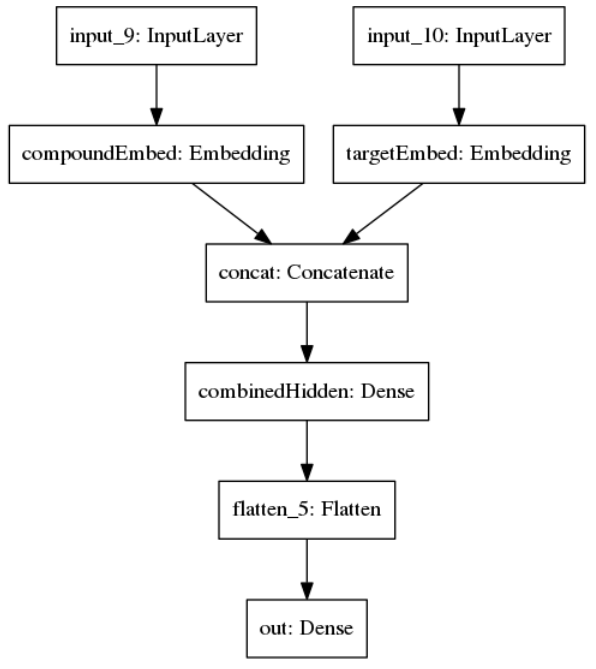
Figure 6. The baseline neural network (NN) architecture with string inputs that undergo embedding.